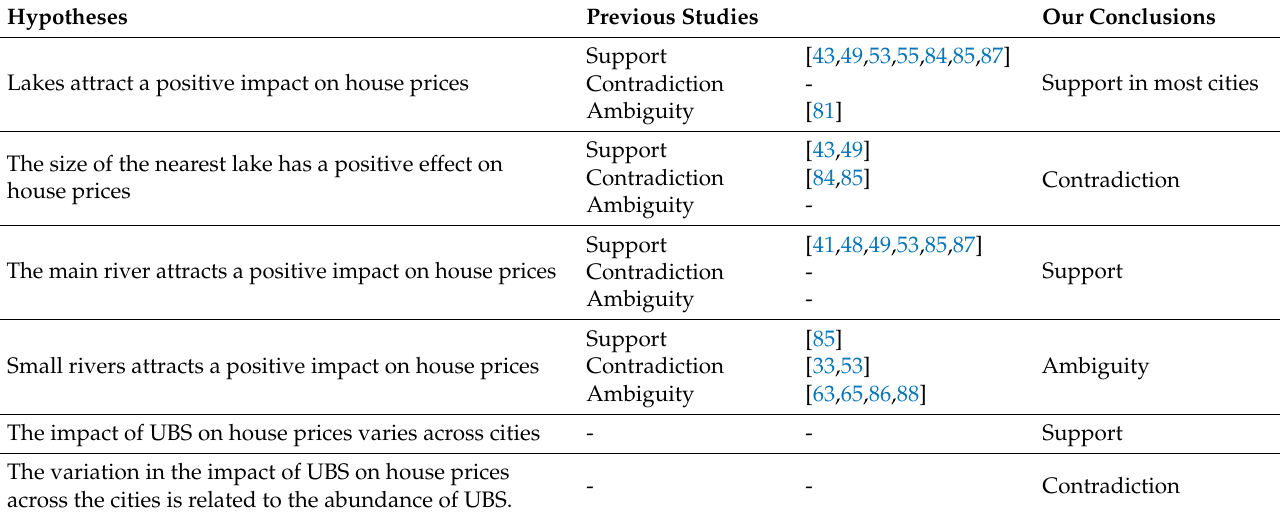
Table 5. Hypotheses, previous studies, and our conclusions and